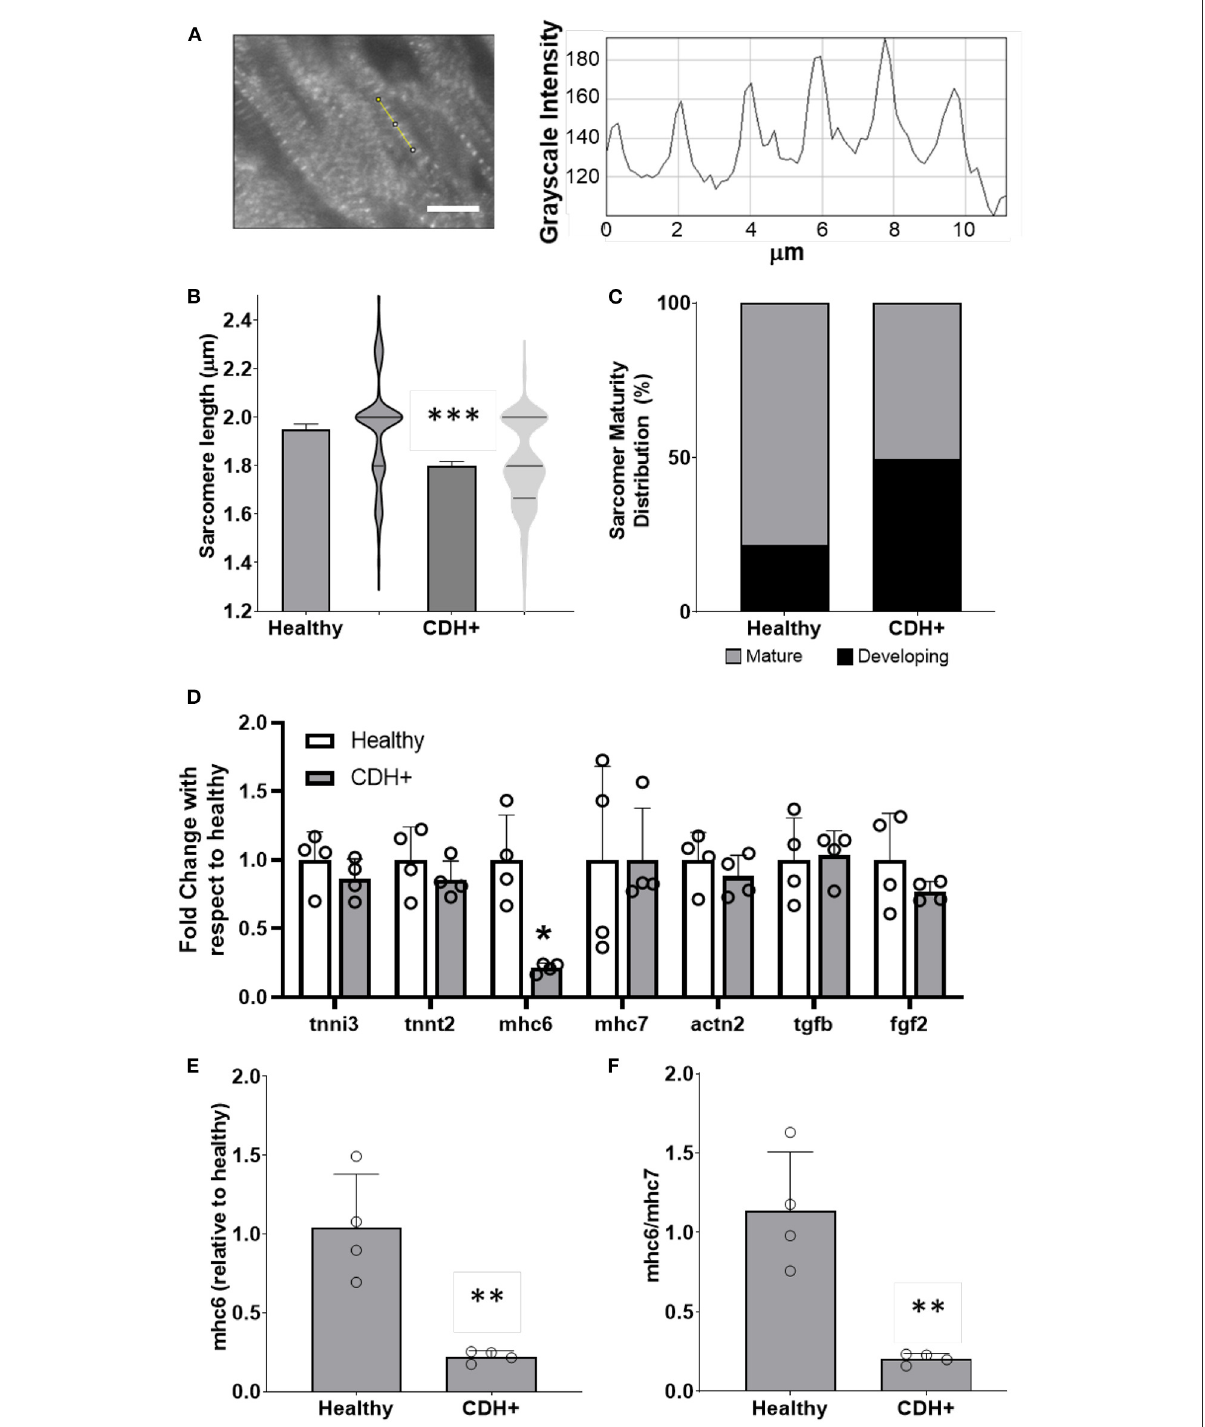
FIGURE3 Maturation assessments in healthy and CDH + hearts. (A) Example of sarcomere staining and measurement in native heart sections. A line is drawn perpendicular to the sarcomeres (yellow) and the profile is plotted in ImageJ. Peak-to-peak distances represent sarcomere lengths. Scale bar represents 10 µ m. (B) Average sarcomere length measurements (mean ± S.E.M. on left, violin plots showing the distribution of the data on right, n > 80 individual cells per condition). *** Denotes p < 0.001. (C) A greater percentage of sarcomeres were mature ( ≥ 1.8 µ m) in healthy vs. CDH + hearts. (D) Gene expression data for panel of genes investigated. * p < 0.05w.r.t. healthy. (E) Gene expression of α MHC (mhc6) as well as the ratio of α to β isoforms (mhc6/mhc7) and (F) was decreased in CDH + hearts ( n = 4). In both cases ** denotes p <